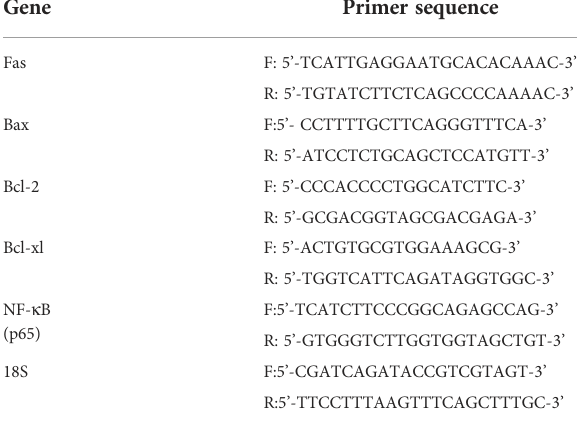
TABLE 2 Primer sequences of the Fas, Bax, Bcl-2, Bcl-xl, NF- k B (p65), and 18S